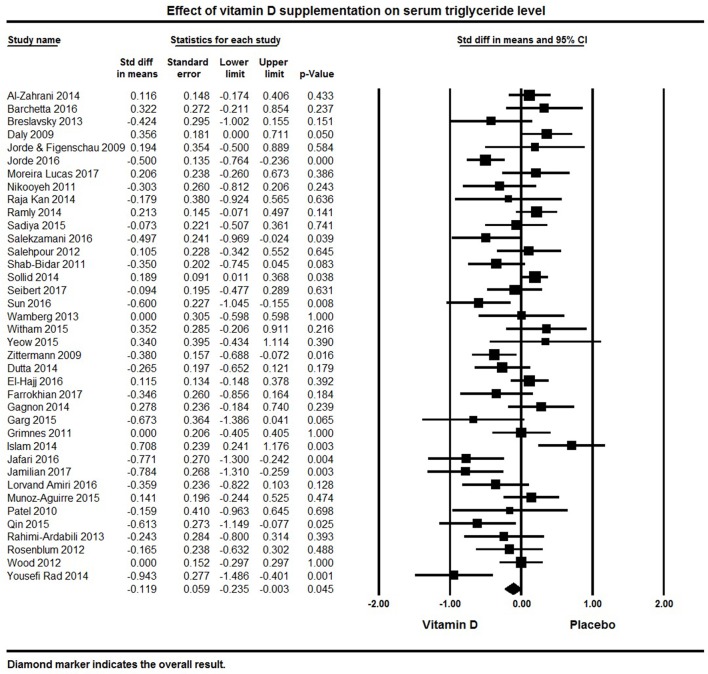
Forest plot detailing standardized mean difference for the impact of vitamin D on serum triglyceride level.